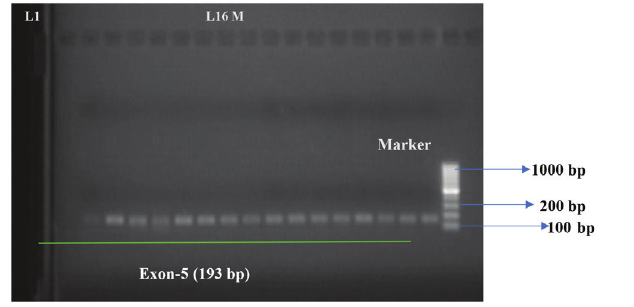
Figure 6. PCR results visualized by Agarose gel electrophoresis of Exon-5 (TP53) Agarose gel electrophoresis (1.5%) results of exon 5 of the human TP53 gene. L1-L16: amplified bands (193bp) of exon 5, L17/M: DNA-marker (1000bp).